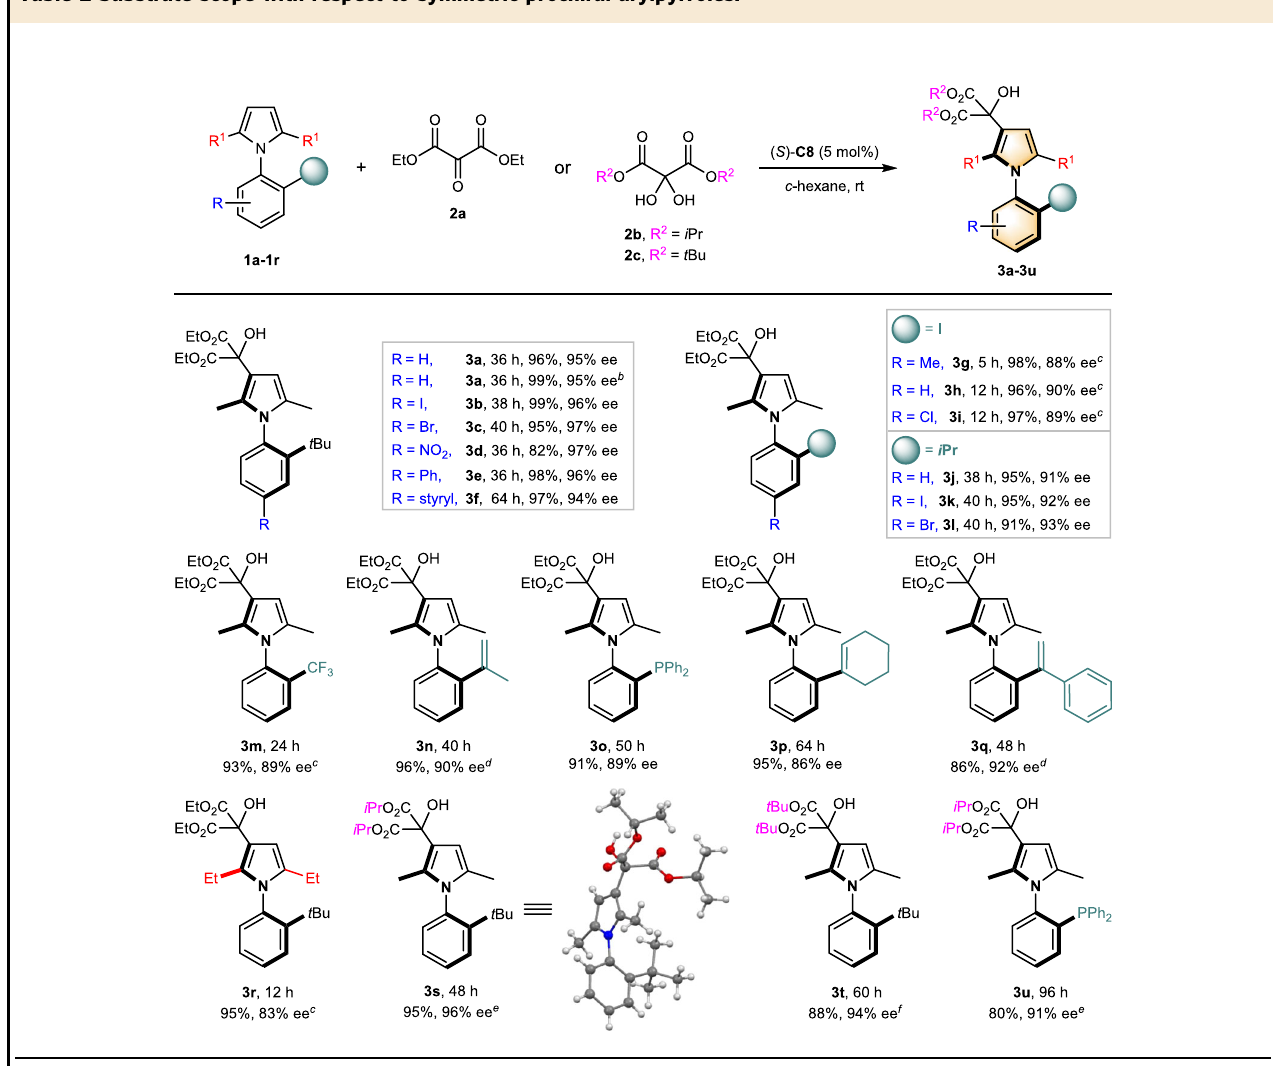
Table 2 Substrate scope with respect to symmetric prochiral arylpyrroles.